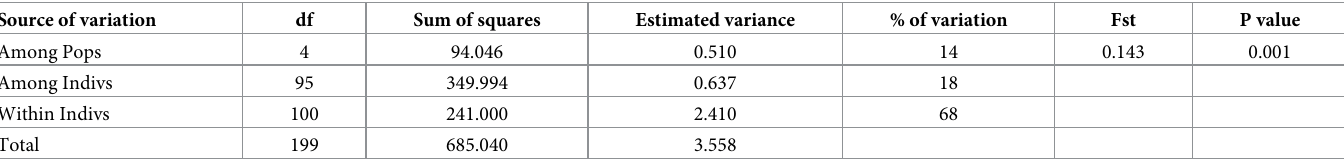
Table 5. Summary of AMOVA for five cocoyam populations based on SSR markers. Source of variation df Sum of squares Estimated variance